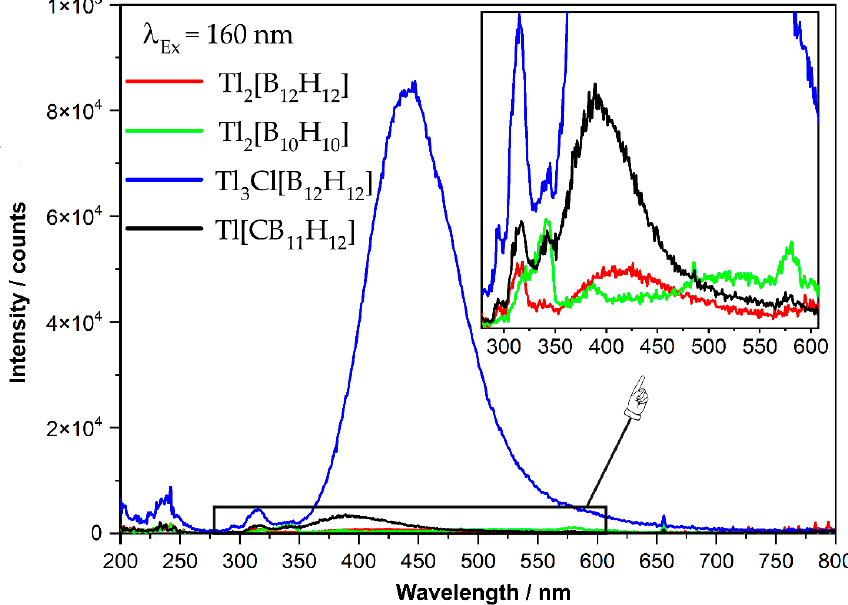
Figure 13. Comparison of the emission spectra of four different thallium(I) closo -hydroborates at an excitation wavelength of λ = 160 nm.